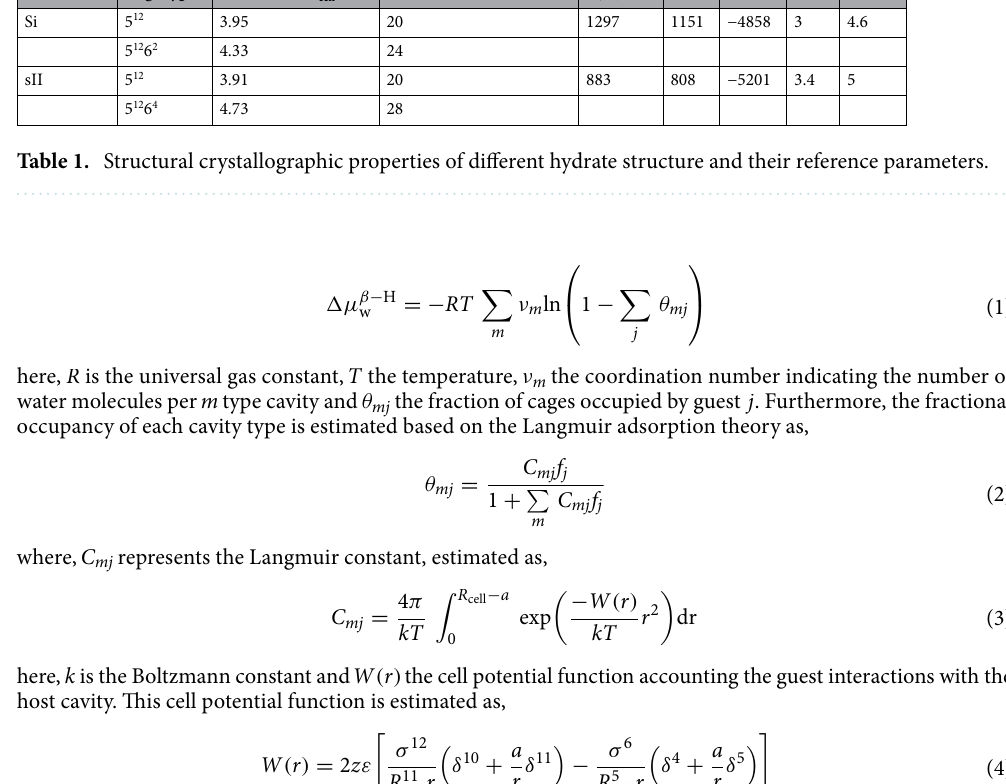
Table 1. Structural crystallographic properties of different hydrate structure and their reference parameters.